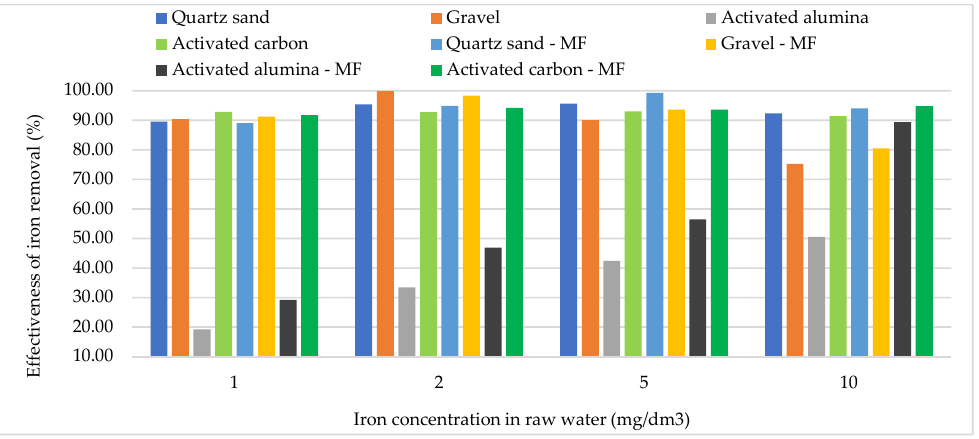
Figure 2. Graph of the dependence of the iron removal efficiency on initial concentration in raw water.